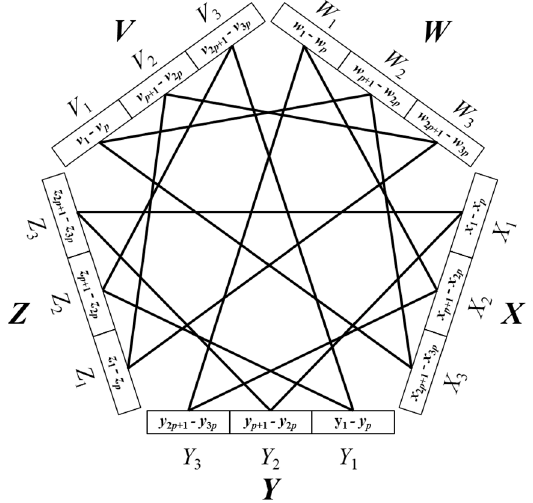
Figure 2. An illustration of the construction used in the k = 5 case of Theorem 2. Lines denote bundles of edges that are absent from a balanced complete 5-partite graph of order n .